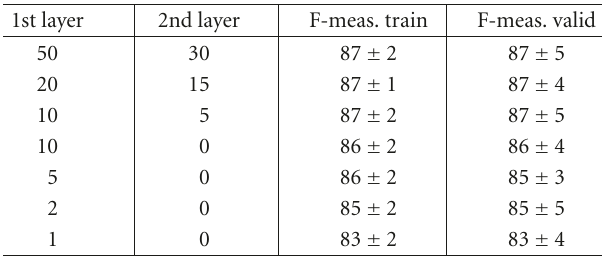
Table 3: Results from tests using di ff erent neural network architec- tures. 1st layer 2nd layer F-meas.